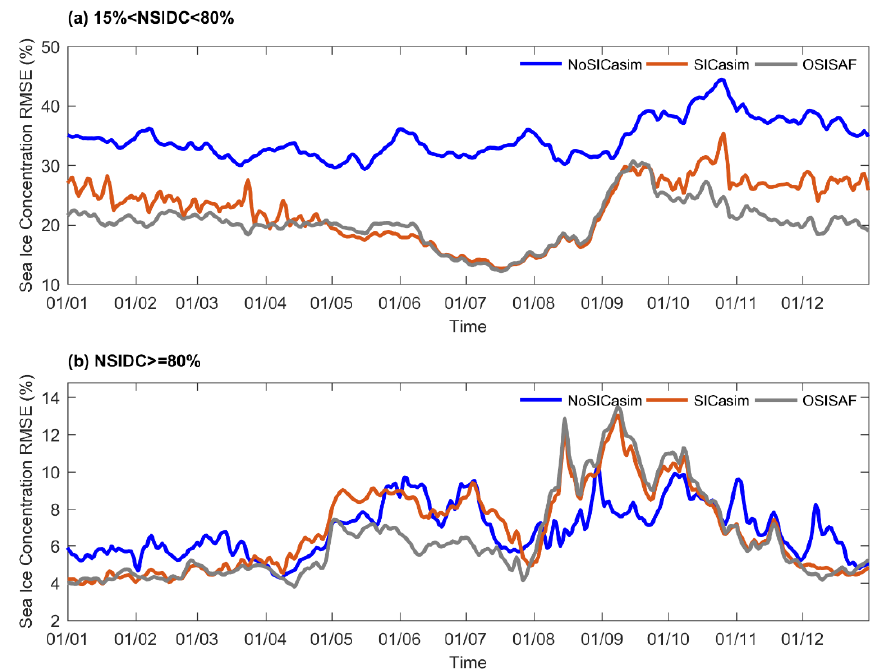
Figure 3. The RMSE time series of sea ice concentration with respect to the NSIDC observation of the Northern Hemisphere from 1 January to 31 December 2019. The results of experiments NoSICasim and SICasim are shown in blue and orange, respectively. The RMSE time series of OSISAF with respect to the NSIDC observation is shown in gray. Note that ( a ) is computed over the area where the NSIDC observation is larger than 15% and below 80%, and ( b ) is computed over the area where the NSIDC observation is larger than 80%. Date format for x-axis is